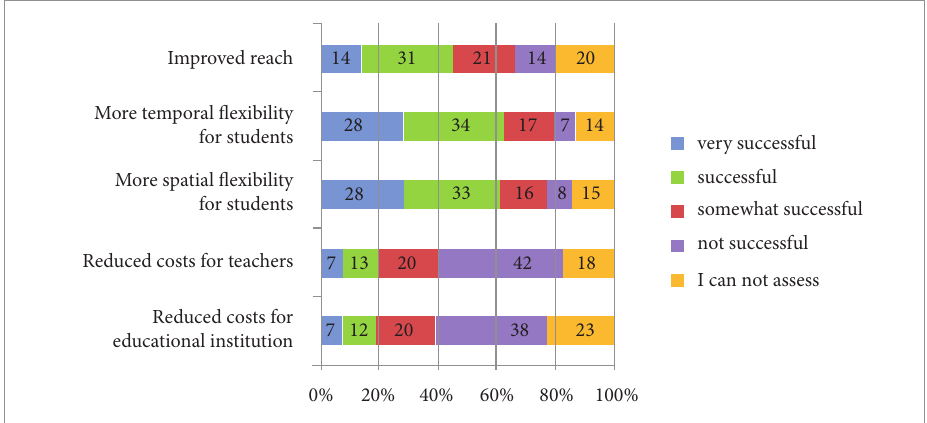
Table 5. Advantages of e-learning in higher educatio